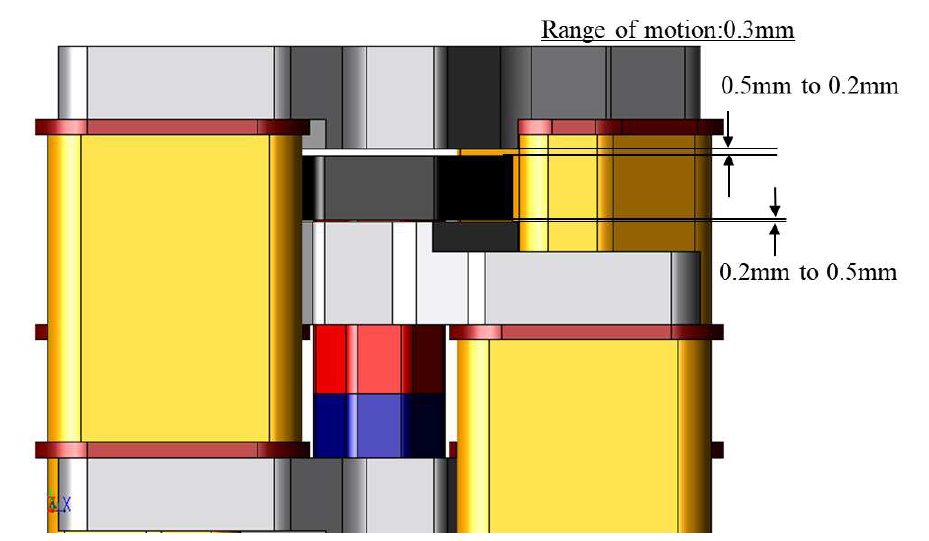
Figure 7. Range of